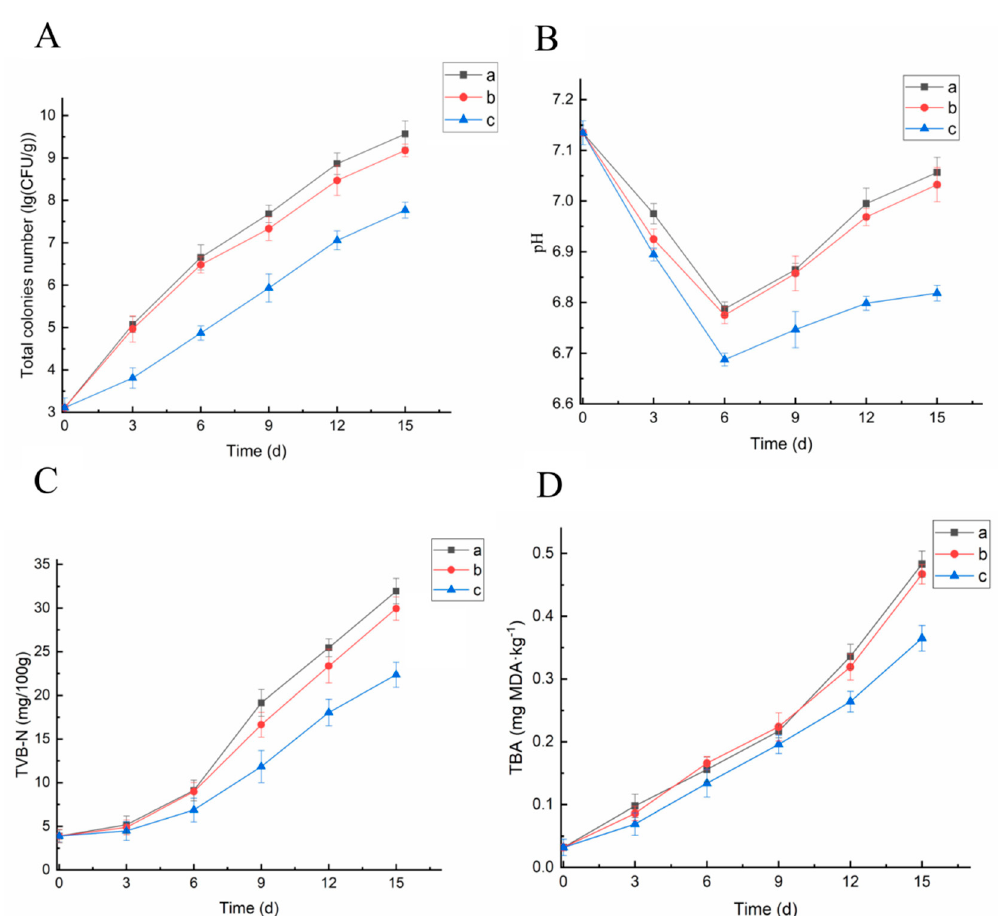
Figure 6. Preservation effect of methyl ferulate electrospun film on sea bass. ( A ) Changes of TVC. ( B ) pH change. ( C ) Changes of TVB-N. ( D ) Changes of TBA (a–c respectively represents blank control, zein fiber membrane, and methyl ferulate/zein fiber membrane).